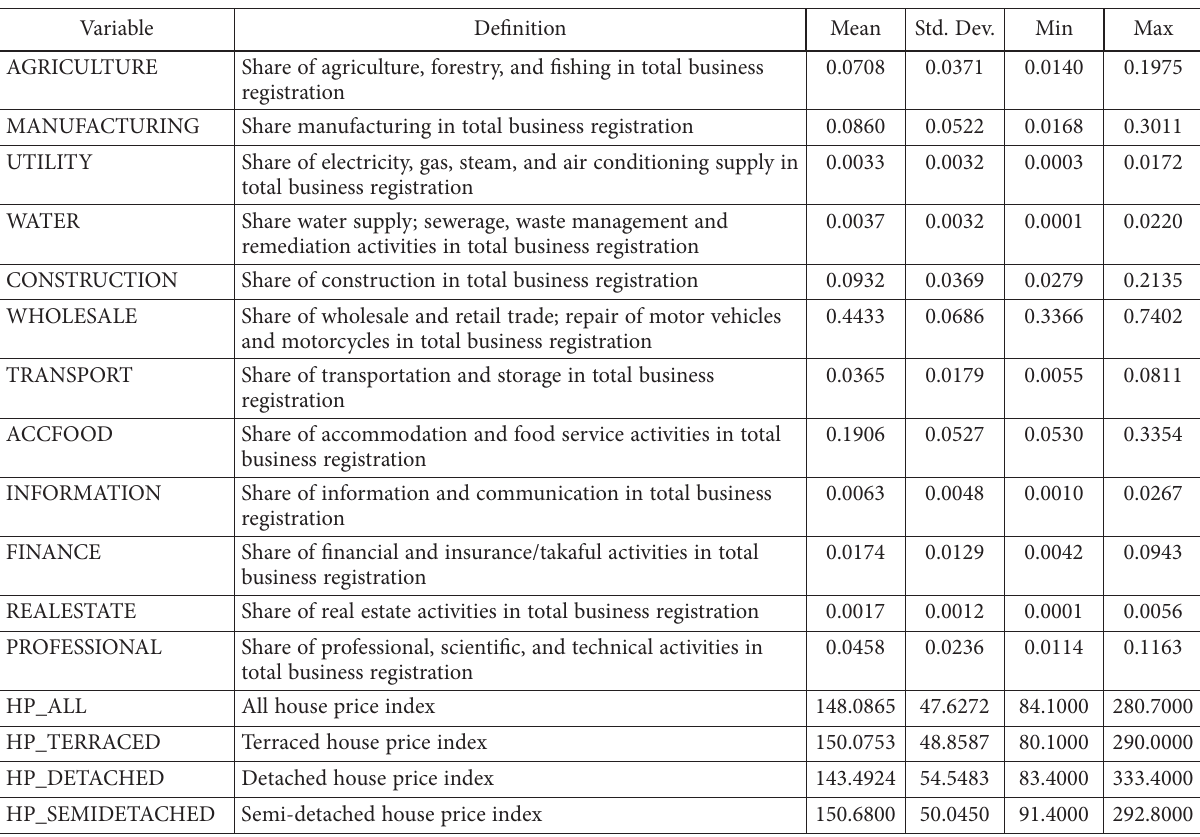
Table 3. Description and summary statistics of variables (before